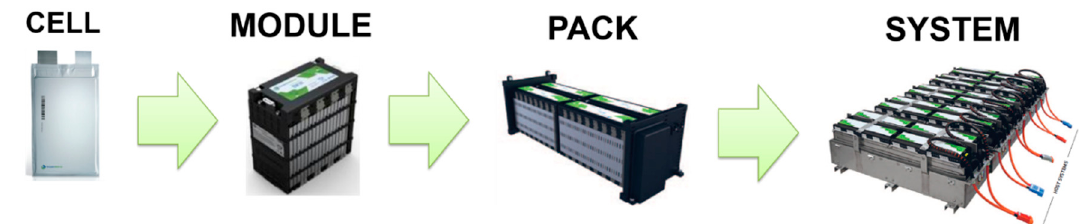
Figure 8. Example of a battery system integration.